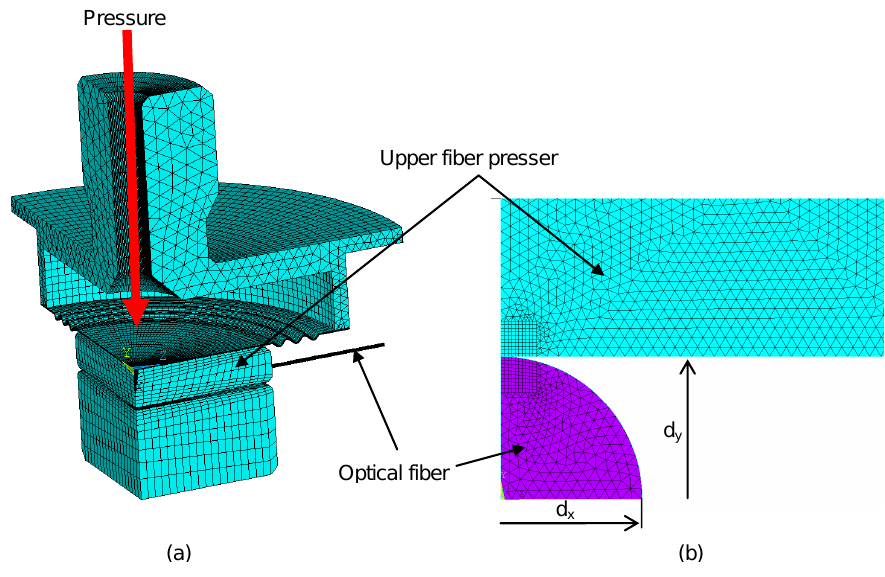
Figure 4. (a) Global and (b) detailed FEM computational model of pressure sensor based on the fiber Bragg grating